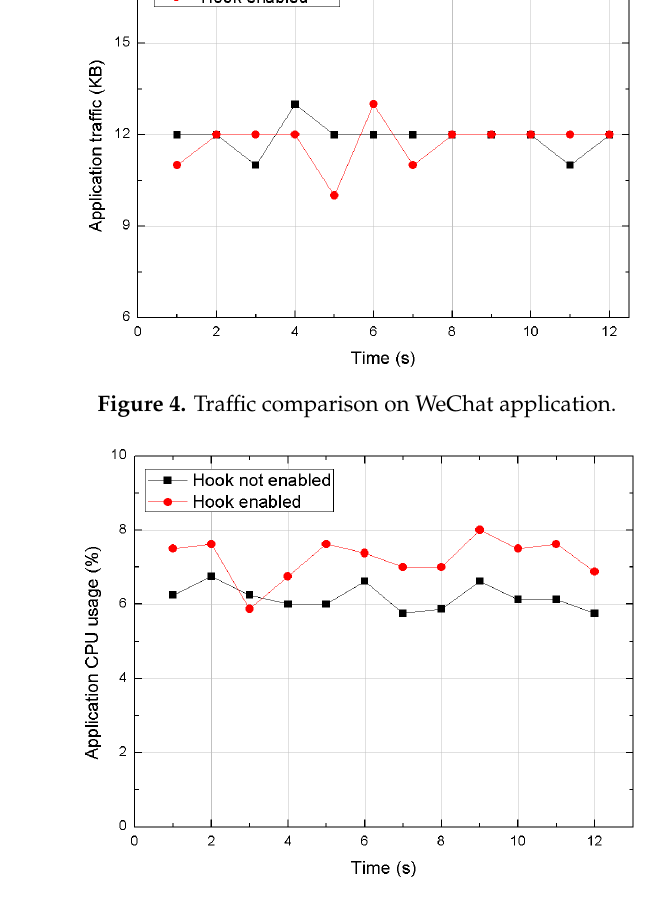
Figure 5. CPU usage comparison on WeChat application. Table 2. Performance on three social